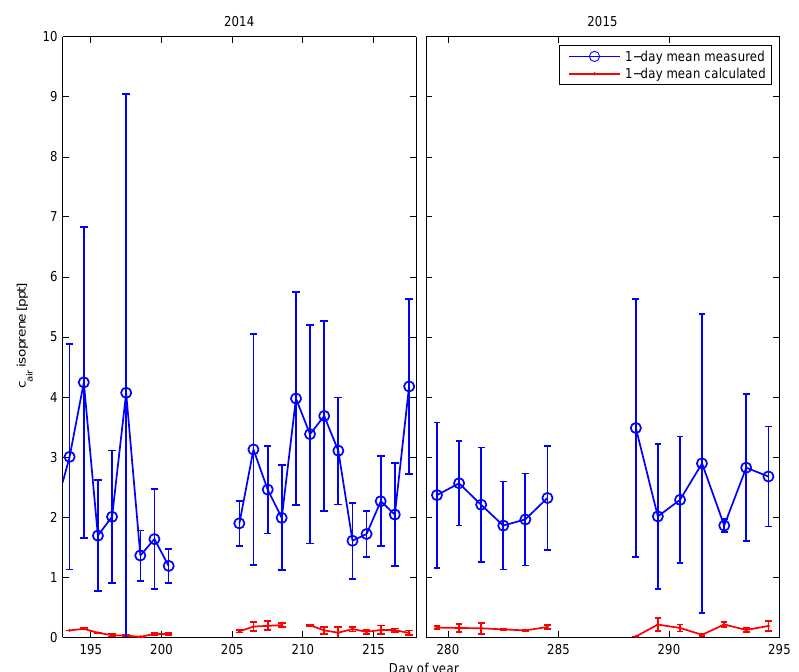
Figure 8. One-day mean measured (blue) and calculated (red) daytime isoprene mixing ratios (ppt) during SPACES/OASIS (2014) and ASTRA-OMZ (2015). Calculated isoprene air values were derived by using the sea-to-air flux, a marine boundary layer height of 800m, and the 1h atmospheric lifetime based on a simple box model approach for each individual